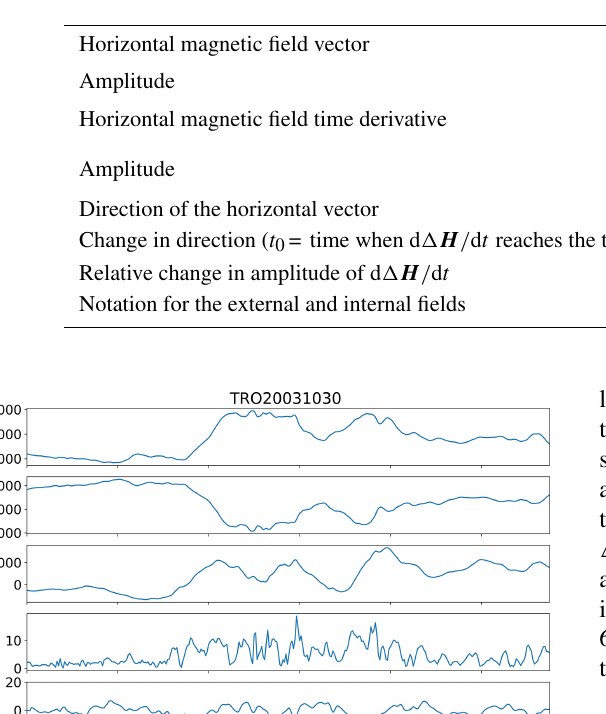
T =1 min. The Halloween event was one of the strongest magnetic storms on record (Pulkkinen et al., 2005; Wik et al., 2009). | d (cid:49) H / d t | values are large ( > 10 nTs − 1 ), indicating also strong GIC. We see that there is little variation in the direction of (cid:49) H (second lowest panel), whereas its time derivative (lowest panel) has much more chaotic